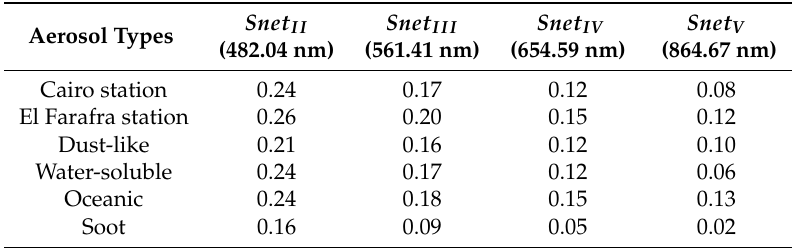
Table 6. Snet 6 SV ( θ s , τ 550 , aer . phys λ ) over the study area for the second to the fifth OLI channel, simulated by the 6SV model for the aerosol microphysical properties as the inverse products of the Cairo and El Farafra AERONET stations and as the basic components of the aerosol included in 6SV (dust-like, water-soluble, oceanic, soot [25]).